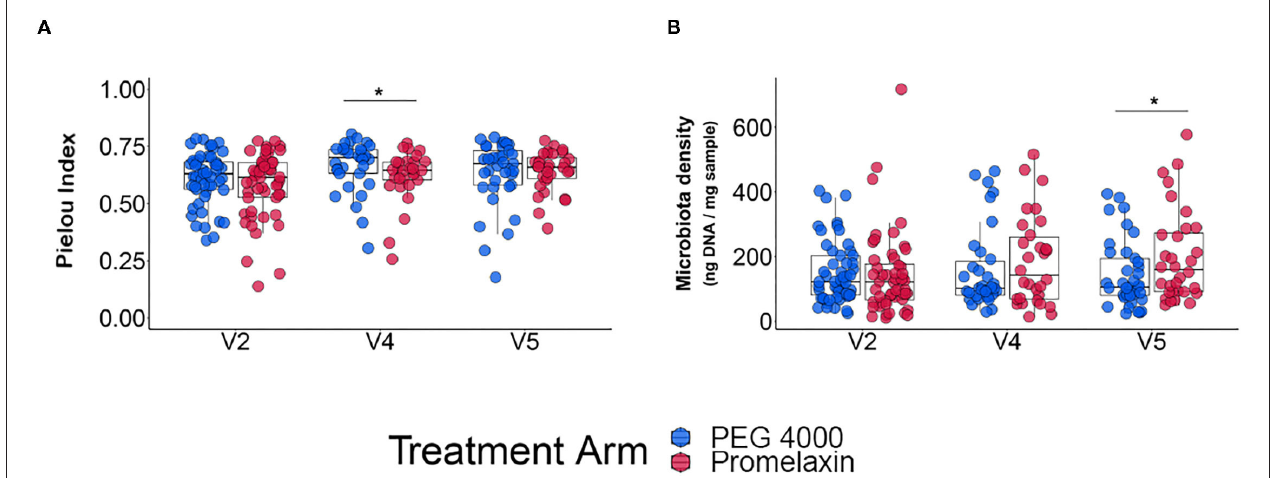
FIGURE 6 | Microbiota analysis. The figure shows individual data and box-plots as median and IQR. (A) Microbiota evenness. (B) Microbiota density. Kruskal-Wallis-test and Student T -test were used for testing differences in microbiota evenness (Pielou’s index) and microbiota density, respectively. * p < 0.05.